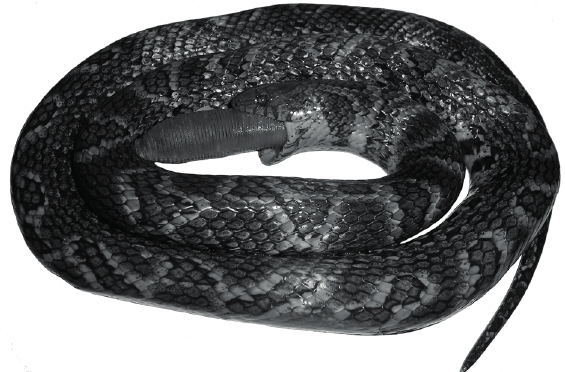
Figure 6 - A female specimen of Atractus major (mePN 5146, SVl 745 mm, Cl 100 mm) preserved with an individual of Oligochaeta (family Glossoscolecidae) on their